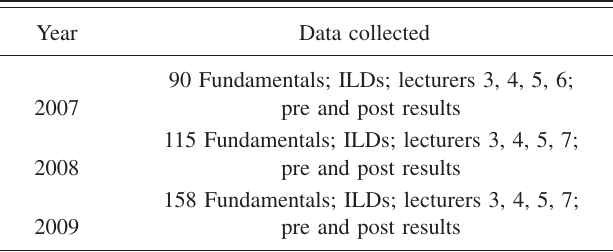
TABLE IV. Various sources of the data used in the analysis of Project 2.